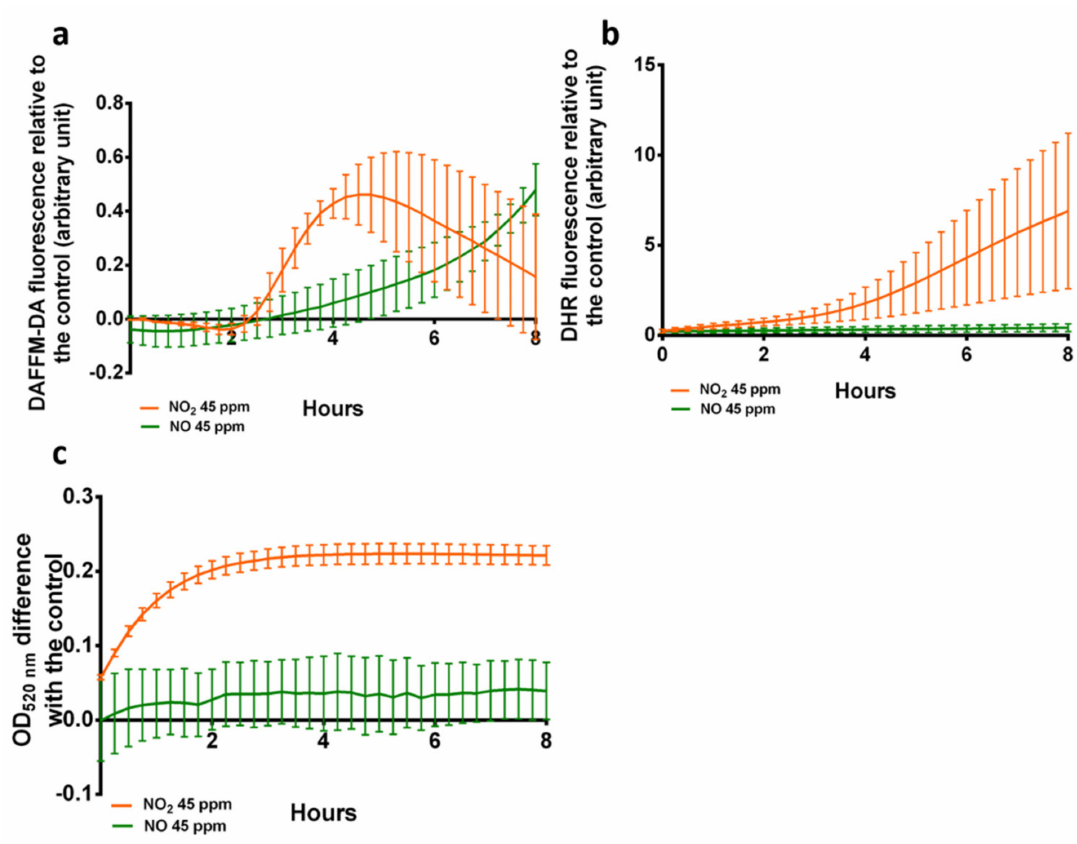
Figure 3. Observation of NOx formation after NO 2 and NO exposure in the bacterial super- natant. ( a ) Kinetics of DAFFM-DA fluorescence in response to NO after exposure to NO and NO 2 . ( b ) Kinetics of DHR fluorescence in response to ONOO − after exposure to NO and NO 2 . ( c ) Optical density at 520 nm of Griess reagent in response to NO 2 − . N =